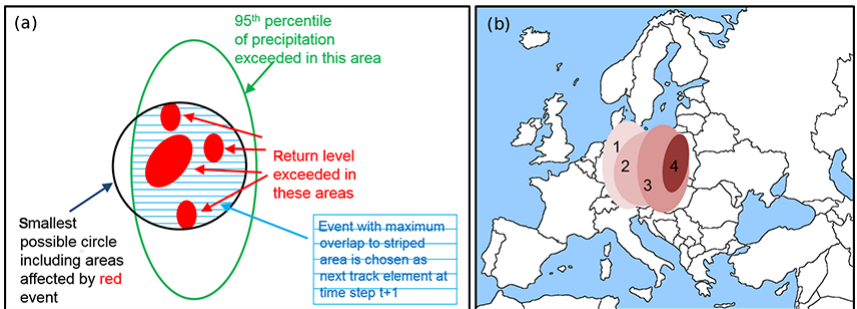
Figure 2. Schematic illustration of the detection and tracking scheme. (a) Grid boxes exceeding the detection threshold are grouped into events. (b) Events are tracked in time and space. See text for further explanation.